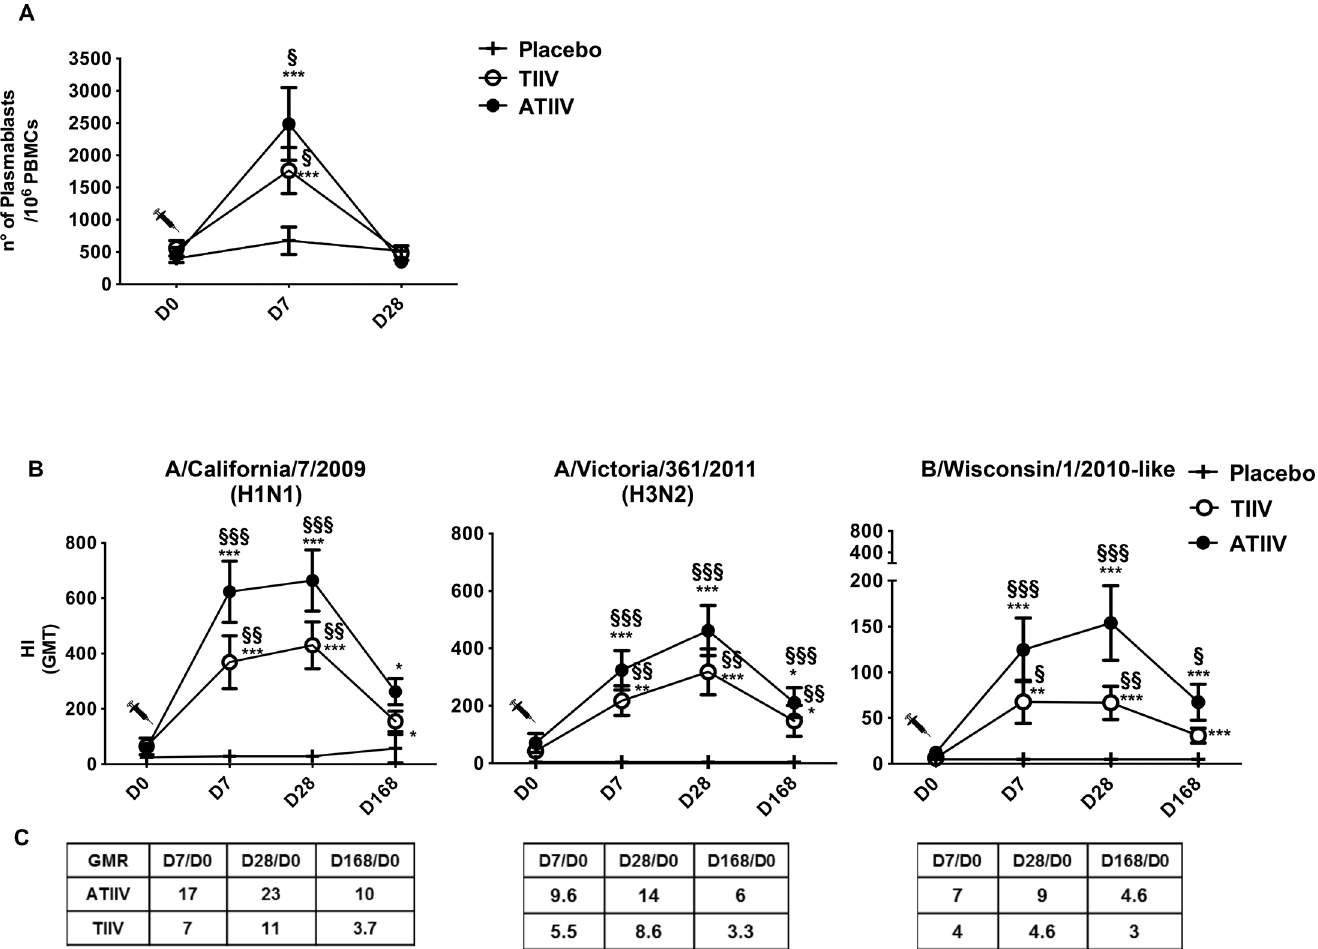
Fig 2. B-cell and functional antibody responses after seasonal influenza vaccination. ( A ) Absolute number of plasmablasts (CD19 + CD20 - CD38 + ) in 10 6 live PBMCs acquired. ( B ) HI Geometric mean titers (GMT) for A H1N1 and H3N2, and B influenza strains at baseline (D0), 7 days (D7), 28 days (D28), and 168 days (D168) after a single dose of influenza vaccine. Data show three cohorts: saline placebo (n=7), TIIV (n=18), and ATIIV (n=17). ( C ) Geometric mean ratio (GMR) for all vaccine strains. Non-parametric Wilcoxon ’ s signed rank test was used for statistical analyses: * p < 0.05, ** p < 0.01, and *** p < 0.001 compared to day 0; § p < 0.05, §§ p < 0.01 and §§§ p < 0.001 compared to saline placebo.